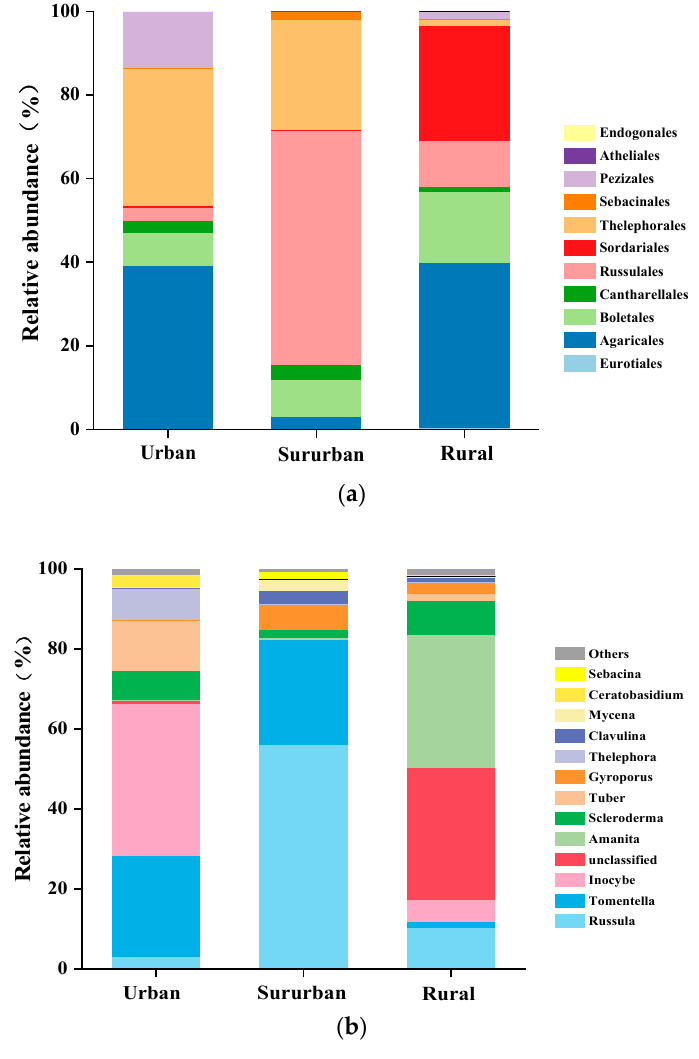
Figure 3. The relative abundance of ECM fungi at the order ( a ) and genus ( b ) levels in the soil of Quercus acutissima forests along the urban–rural gradient.